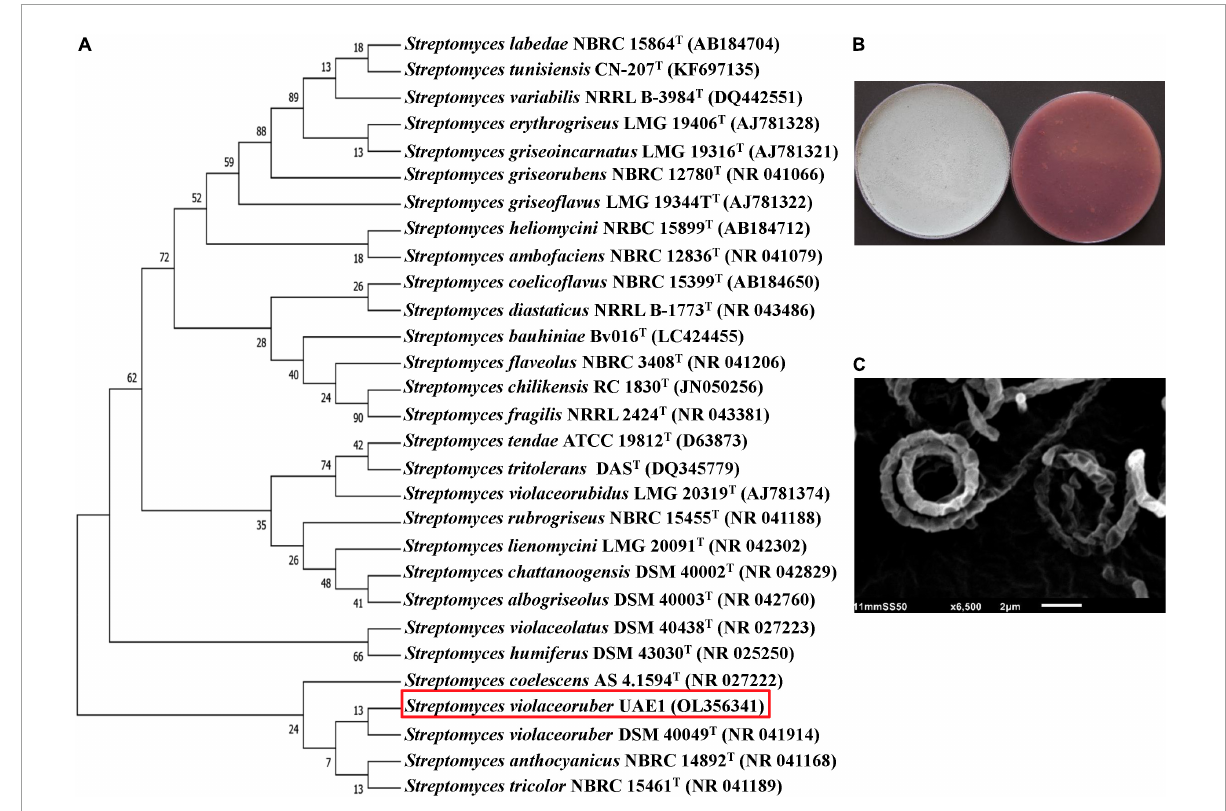
FIGURE2 Taxonomic identification of the ACCD-producing Streptomyces violaceoruber UAE1 (BCA2). (A) The dendrogram showing the phylogenetic relationships between S. violaceoruber UAE1 (isolate #26; 1519 bp; OL356341) and other members of Streptomyces spp. on the basis of 16S rRNA sequences. (B) Gray aerial (left) and violet substrate mycelia with the production of violet pigment on the reverse side of cultures (right) growing on ISP3 medium supplemented with yeast extract; and (C) scanning electron micrograph (6,500 × ) of the section Spirales spore chains (closed spirals) with 10–50 smooth-surfaced spores/chain of S. violaceoruber UAE1. In (A) , numbers at nodes indicate percentage levels of bootstrap support based on a neighbor-joining analysis of 500 resampled datasets. GenBank accession numbers are given in parentheses. BCA, biological control agent; ACCD, 1-aminocyclopropane-1-carboxylic acid